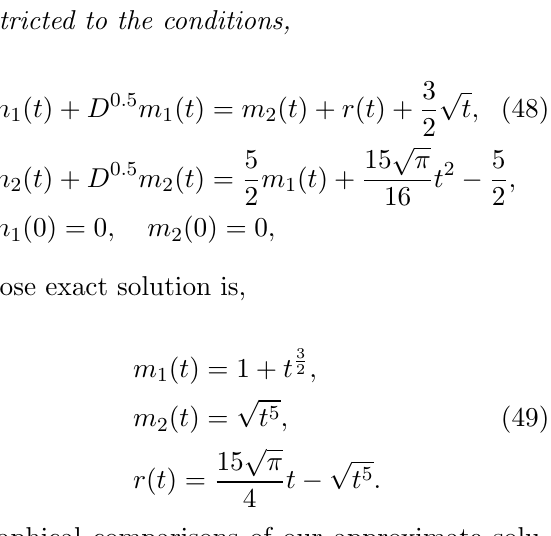
Graphical comparisons of our approximate solu- tion and (49) is depicted in Fig. 5 and fig.